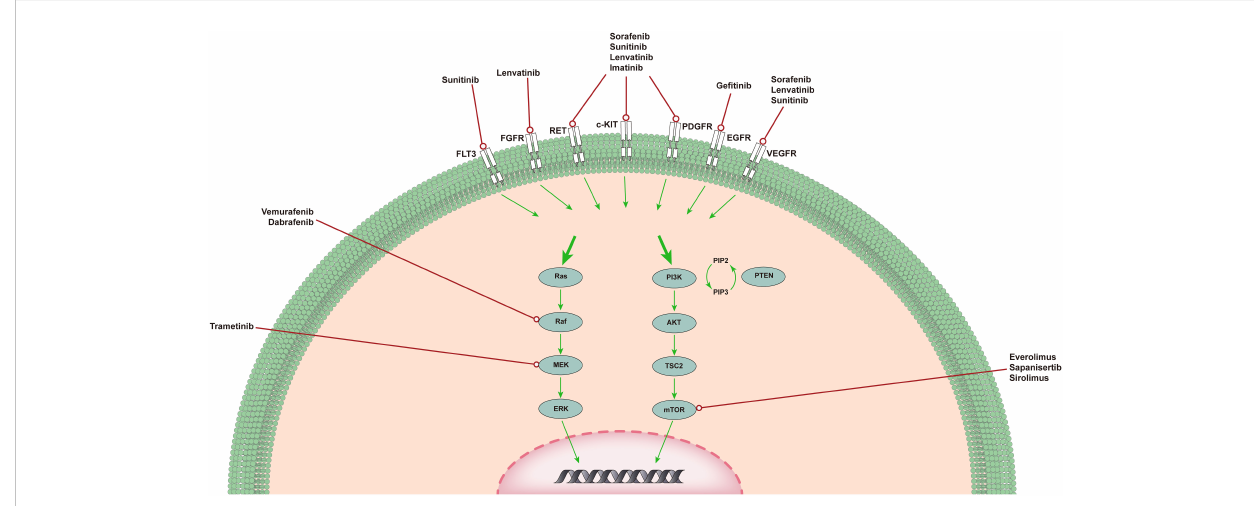
FIGURE 1 The MAPK pathway and PI3K/AKT/mTOR pathway in ATC. MAPK and PI3K/AKT pathways in ATC. The MAPK and PI3K/AKT pathways are responsible for angiogenesis, proliferation, and tumorigenesis. Shown are several medications capable of speci fi c mutations, targeting upstream receptor tyrosine kinases, and genetic rearrangements that have completed or are in clinical trials of targeted therapy for